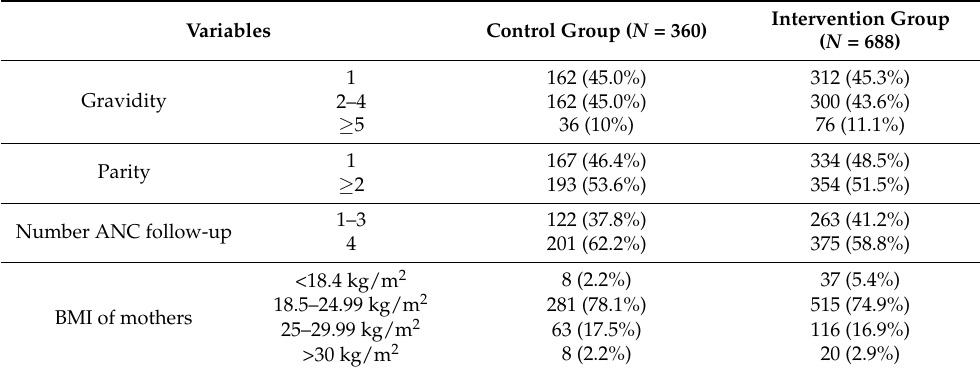
Table 2. Obstetric characteristics of the study participants in the intervention compared to control group, in Amhara public Health facilities,